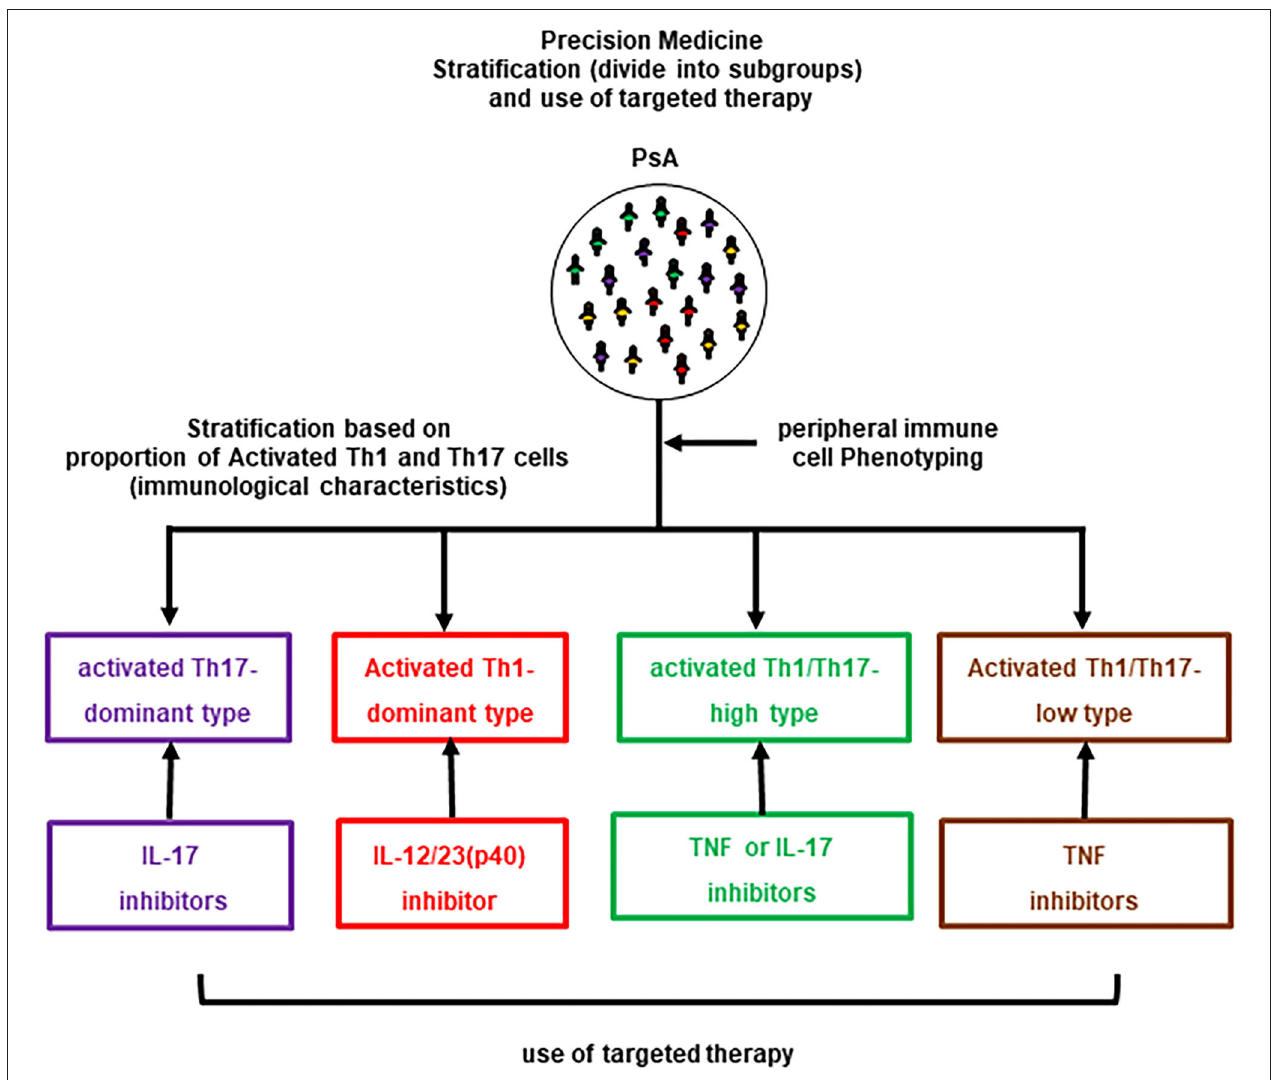
FIGURE 1 | Selective use of bDMARDs in PsA based on the lymphocyte